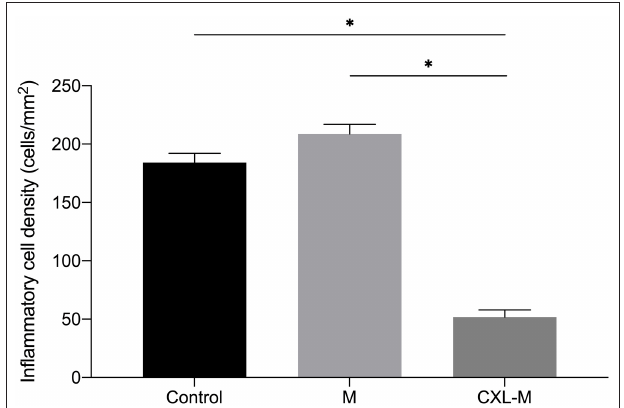
FIGURE 6 | The inflammatory cell density in three groups 28 days after treatment (CXL/M). The graph shows the inflammatory cell density of the CXL-M at the end of the study was significantly less than that of other two groups (all P < 0.0001). * P <